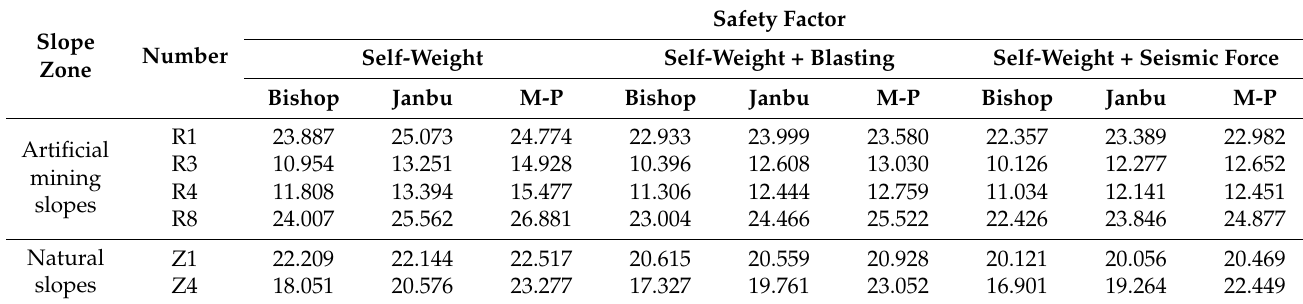
Table 9. Calculation results of limit equilibrium method.